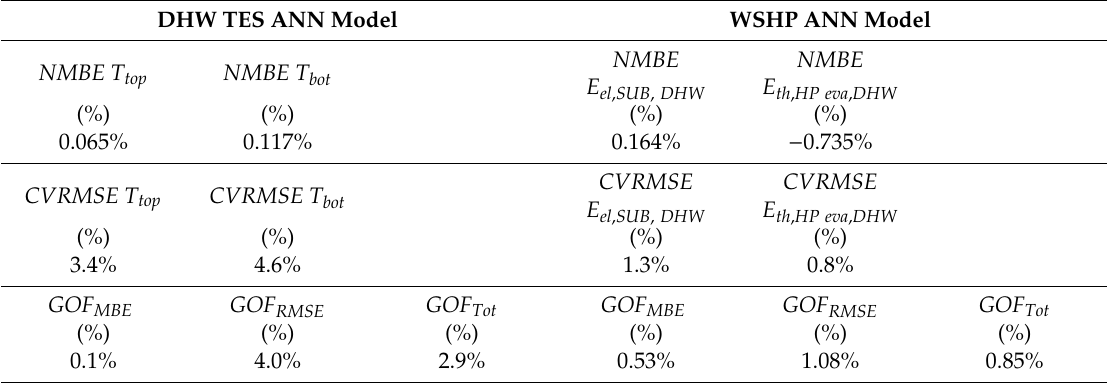
T top and T bot : temperature at the top and bottom, and HP: heat and power.